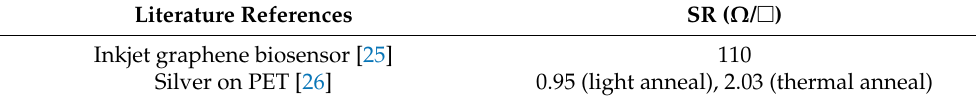
Table 4. Reported sheet resistance values for flexible printed sensors from relevant literature.